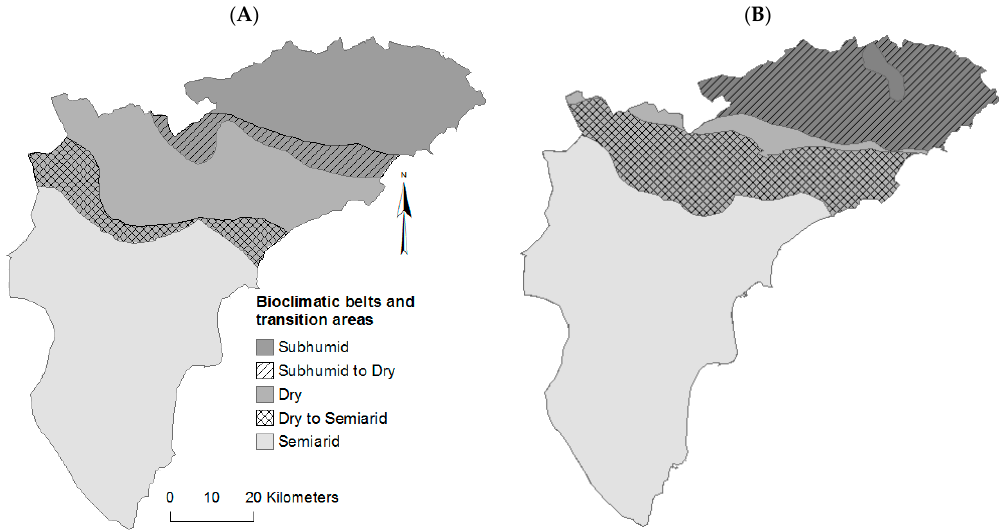
Figure 4. Shifts of the bioclimatic belts in the province of Alicante. ( A ) Changes observed between 1953–1982 and 1983–2012 (dashed areas show transition zones). ( B ) Changes estimated for 2070–2099 with respect to 1983–2012 period according to the high scenario RCP8.5 (Representative Concentration Pathways 8.5) (the average of nine CMIP5, Coupled Model Intercomparison Project Phase 5, climate models).